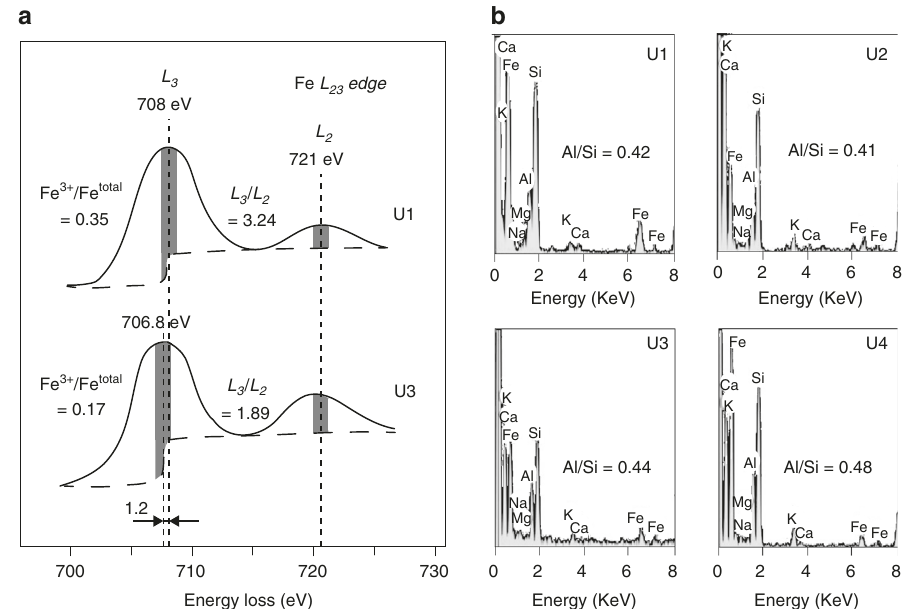
Fig. 4 Fe-oxidation states and elemental composition of illite. a Electron energy loss spectroscopy spectra of illite grains for U1 and U3 measuring a chemical shift of Fe L 3 edges (~1.2 eV). A calculated integral intensity ratio of Fe L 3 /L 2 (3.24 and 1.89) for illite corresponds to Fe 3 + /Fe total of 35 and 17% for U1 and U3, respectively. b Elemental composition typical of illite with 9 – 14 wt% of Fe contents and 0.41 – 0.44 of Al/Si for U1 – 3 compared to 6 wt% of Fe and 0.48 of Al/Si for